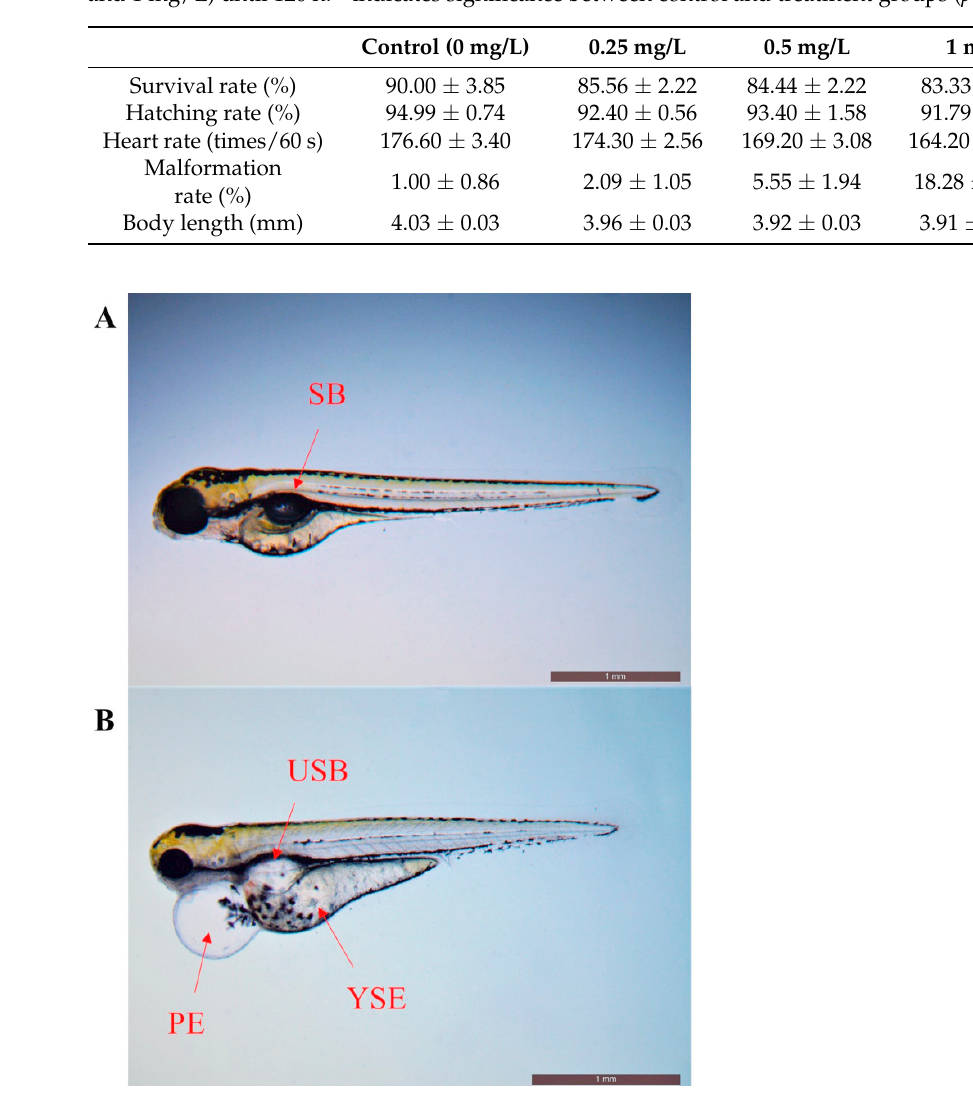
Table 2. Developmental parameters in zebrafish larvae after exposing to difenoconazole (0, 0.25, 0.5, and 1 mg/L) until 120 h. * indicates significance between control and treatment groups ( p < 0.05).